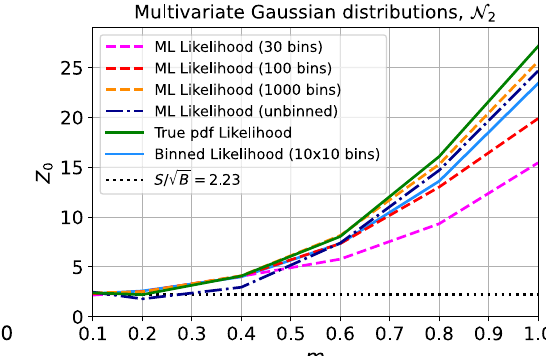
Fig. 4 Left panel: AUC obtained with XGBoost (red curve) and the optimal classifier calculated with Eq. (9) (green dotted curve) for the multivariate Gaussian example of Fig. 2, but with increasing signal- background separation m . Right panel: discovery significance calcu- lated with various methods for the same example. Here we fixed